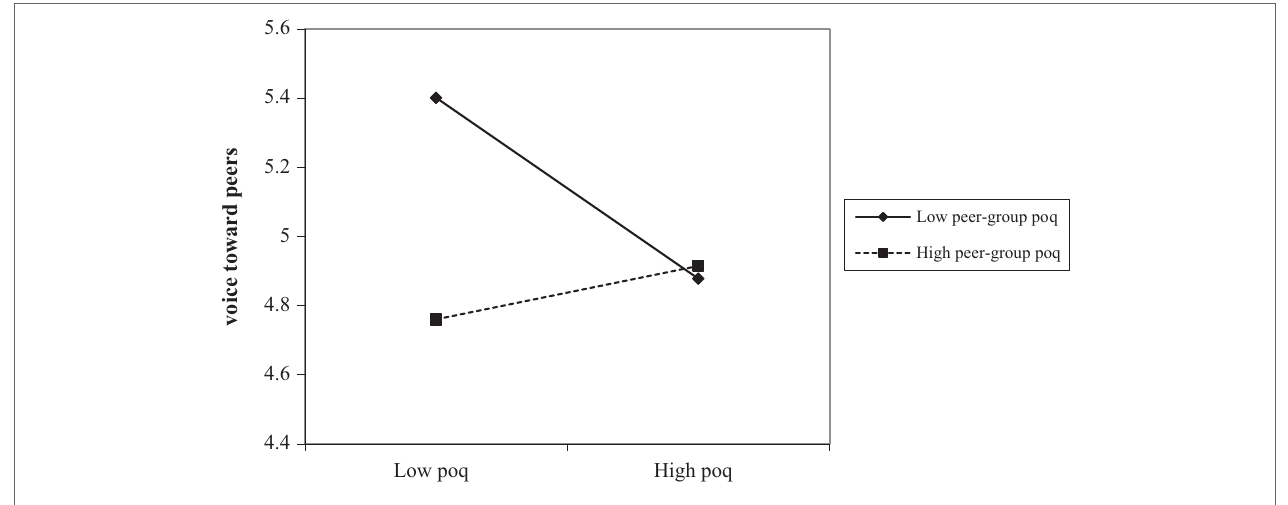
FIGURE 2 | The interaction between perceived overqualification and peer group perceived overqualification on voice toward peers.